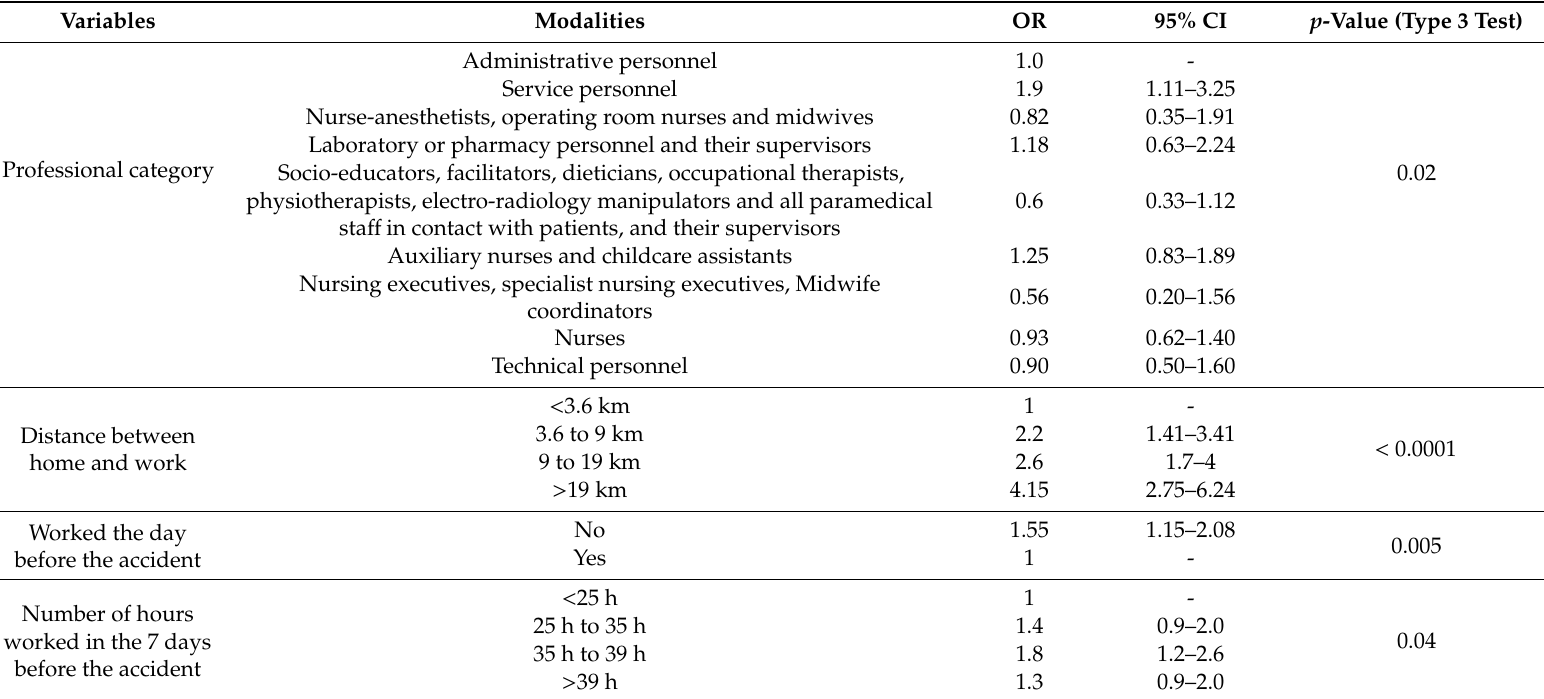
Table 3. Multivariate analyses of commuting accidents from 2012 to 2016 in cases and controls drawn from non-physician sta ff working in a large teaching hospital